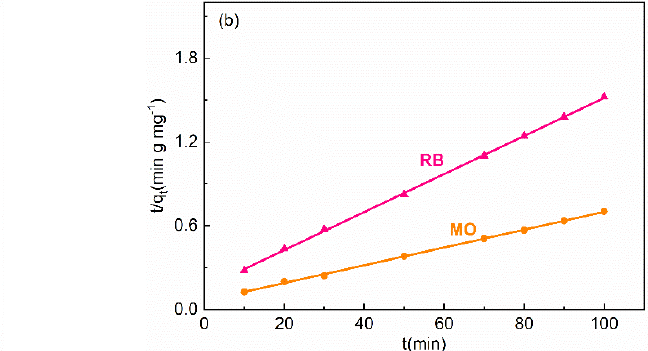
8 of 13 Figure 4. Possible mechanism of synergetic interplay for ( a ) MO and ( b ) RB adsorption on 160-MIL- 101. The possible mechanism of improvement of MO adsorption by spherical MIL- 101(Cr) may be attributed to its higher surface area and the positive charge may be more evenly distributed on the surface. The former could significantly increase the adsorption capability of MO, while the latter is also conducive to promoting adsorption of anionic MO. Thus, in our case, the spherical MIL-101(Cr) (160-MIL-101) presented higher adsorption capability of MO than other octahedral MIL-101(Cr). The time-dependent adsorption capacity of 160-MIL-101 for dyes was investigated, as shown in Figure S7. The adsorption kinetics curves which were fitted with Equations